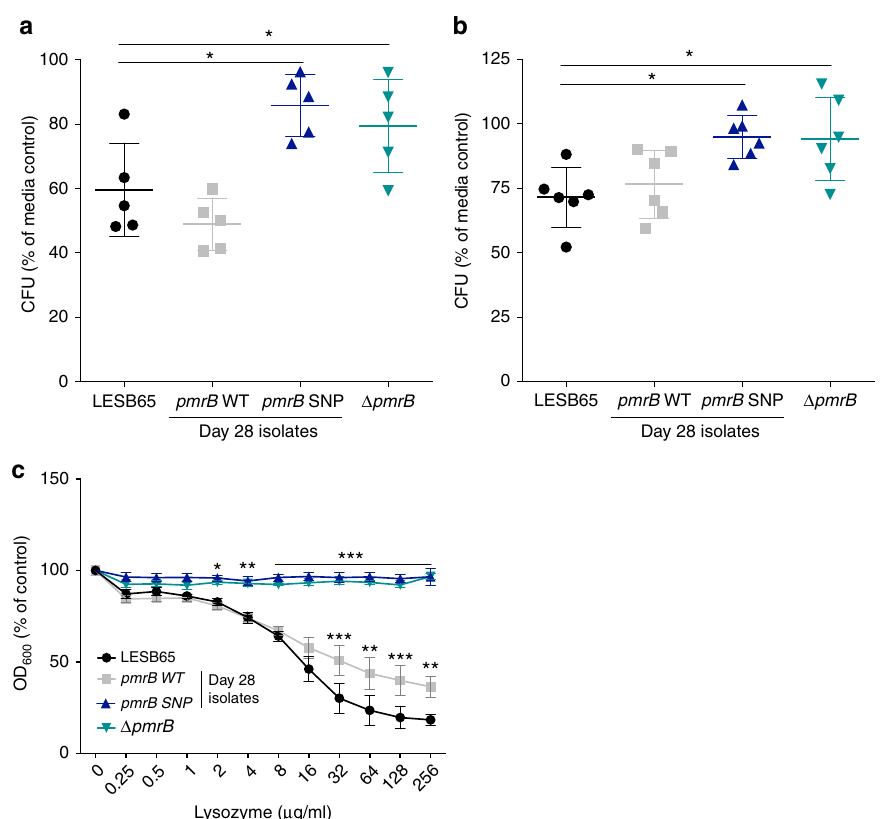
Fig. 1 P. aeruginosa pmrB mutants are resistant to host defence molecules and lysozyme killing. Supernatants from phorbol 12-myristate 13-acetate (PMA)- stimulated ( a ) HL-60 or ( b ) mouse bone marrow neutrophil cultures were transferred to mid-log growth P. aeruginosa . Colony forming units (CFU) as a percentage of control. Control bacteria were exposed to supernatant from non-activated (no PMA) HL-60 cultures. c Optical density at 600nm of P. aeruginosa grown in the presence of lysozyme (mean± s.d.). Results are expressed as a percentage of the no-lysozyme control for each isolate and are a composite of 3 biological replicates per isolate, each containing 3 technical replicates. Asterisks (*) represent signi fi cant differences in ANOVA performed on CFU counts ( a , b ) or OD readings, with lysozyme as a covariant ( c ), with Dunnett ’ s multiple comparison test vs. LESB65. * p < 0.05, ** p < 0.01, *** p <